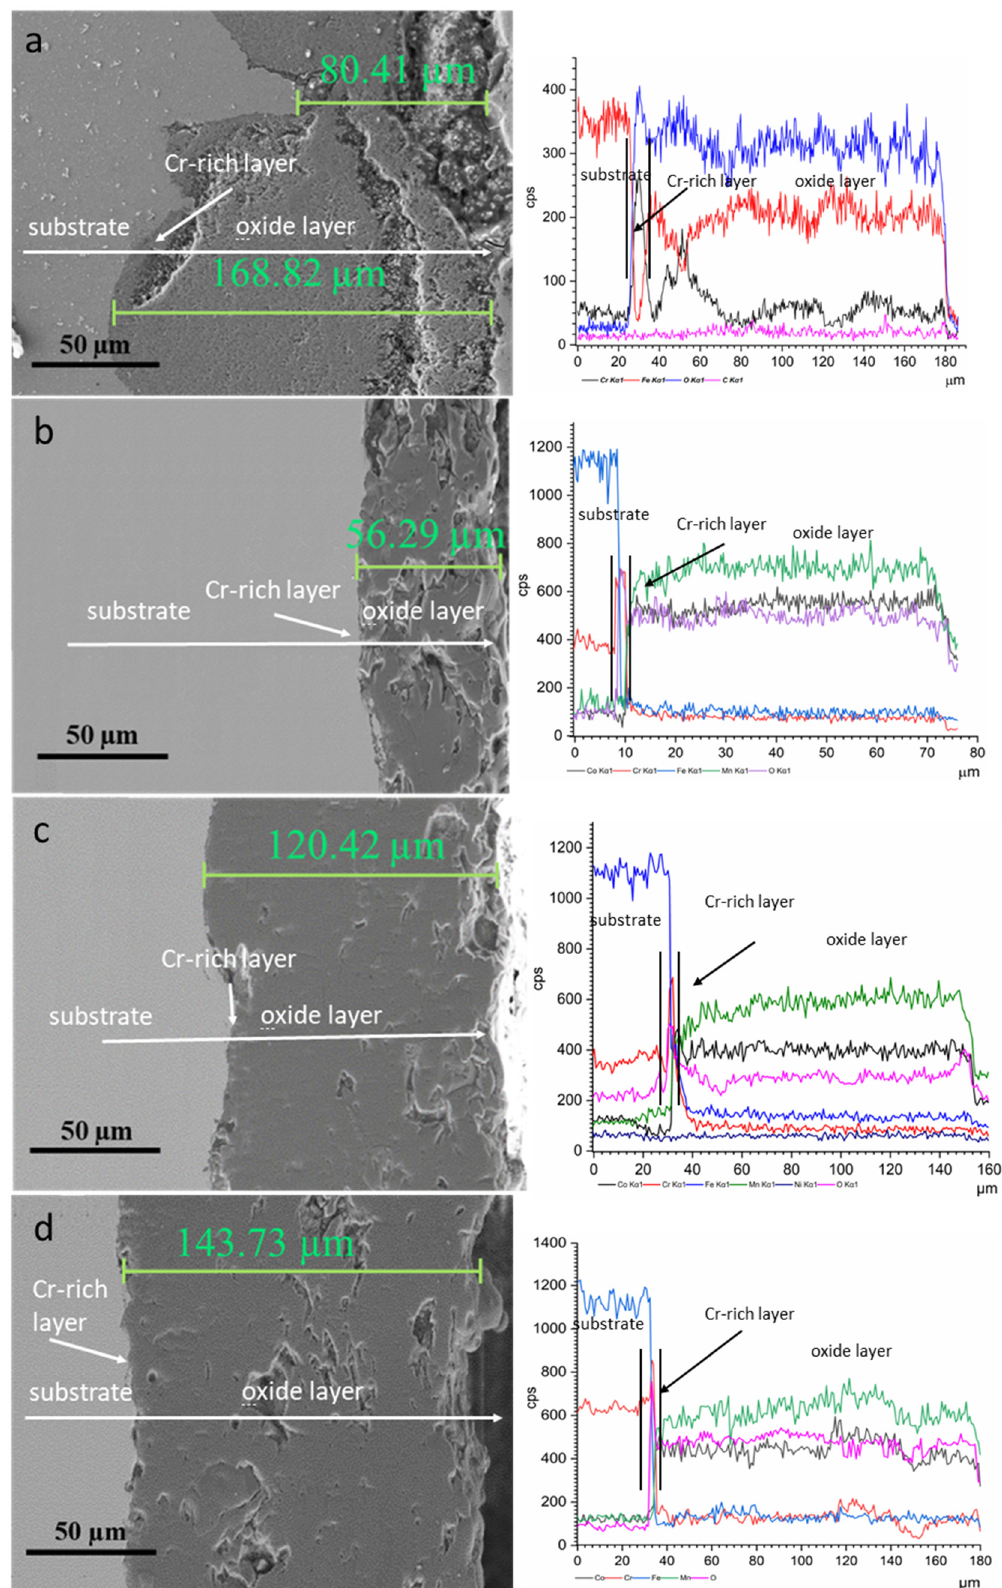
Figure 7. Cross-section images and EDS line analysis for ( a ) bare steel and ( b – d ) CoMnO30, CoMnO35, and CoMnO38 after the isothermal test.